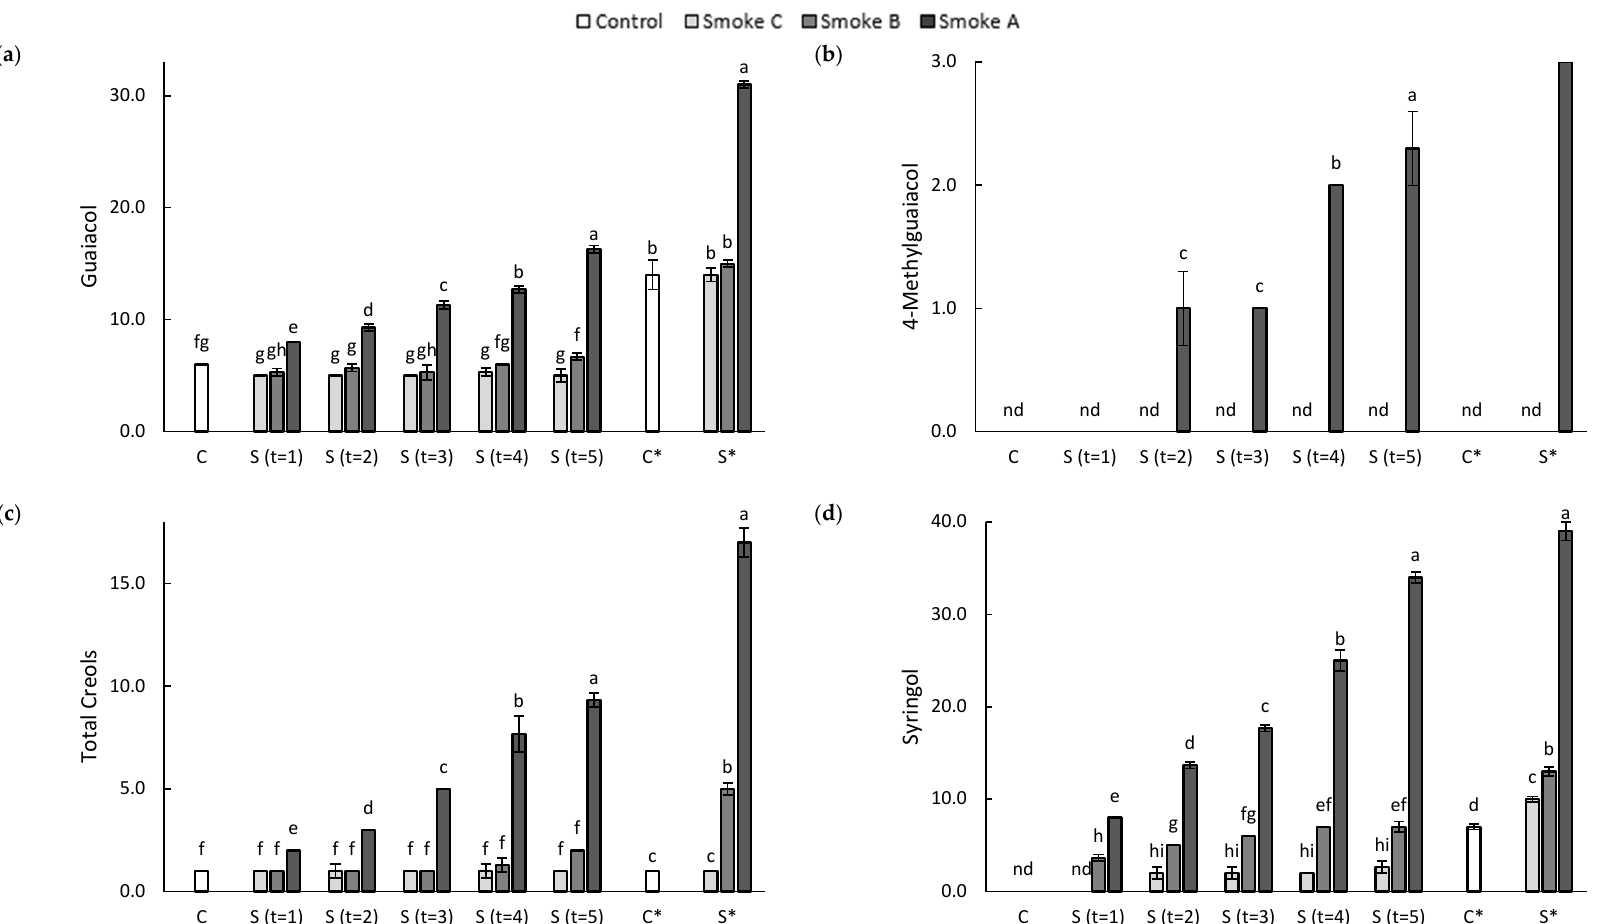
Figure 2. Concentrations of ( a ) guaiacol, ( b ) 4-methylguaiacol, ( c ) cresols and ( d ) syringol in control (C) and smoke-affected (S) Shiraz grapes ( µ g/kg) sampled at hourly time points (i.e., t = 1, 2, 3, 4 and 5 h) and wines ( µ g/L, denoted by an asterisk). Data are the means of three replicates ± standard error (where available). Different letters indicate statistical significance ( p ≤ 0.05, one-way ANOVA) amongst grape and wine samples; nd = not detected.